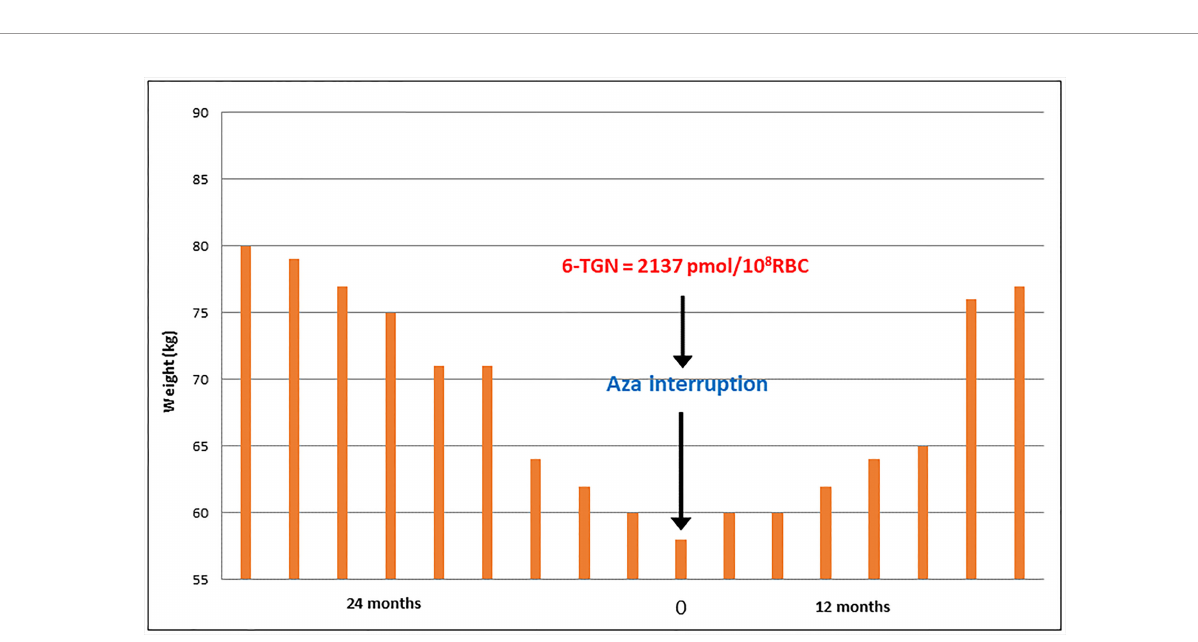
FIGURE 2 | Case 2: Follow-up of patient body weight over a 36-month period, including cessation of AZA